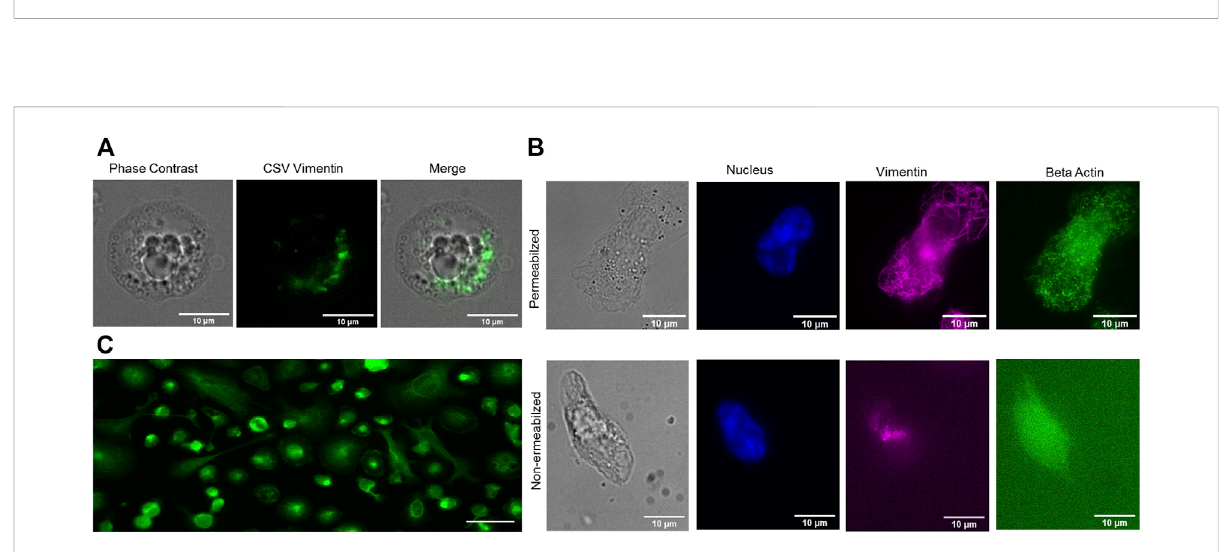
FIGURE 2 (A) Live cell imaging of activated macrophages using CSV antibody. (B) Comparison of permeablized vs. non permeablized activated macrophages labelled using beta actin antibody and anti vimentin V9 antibody (Nucleus, blue:actin, green: vimentin, magenta). (C) M1